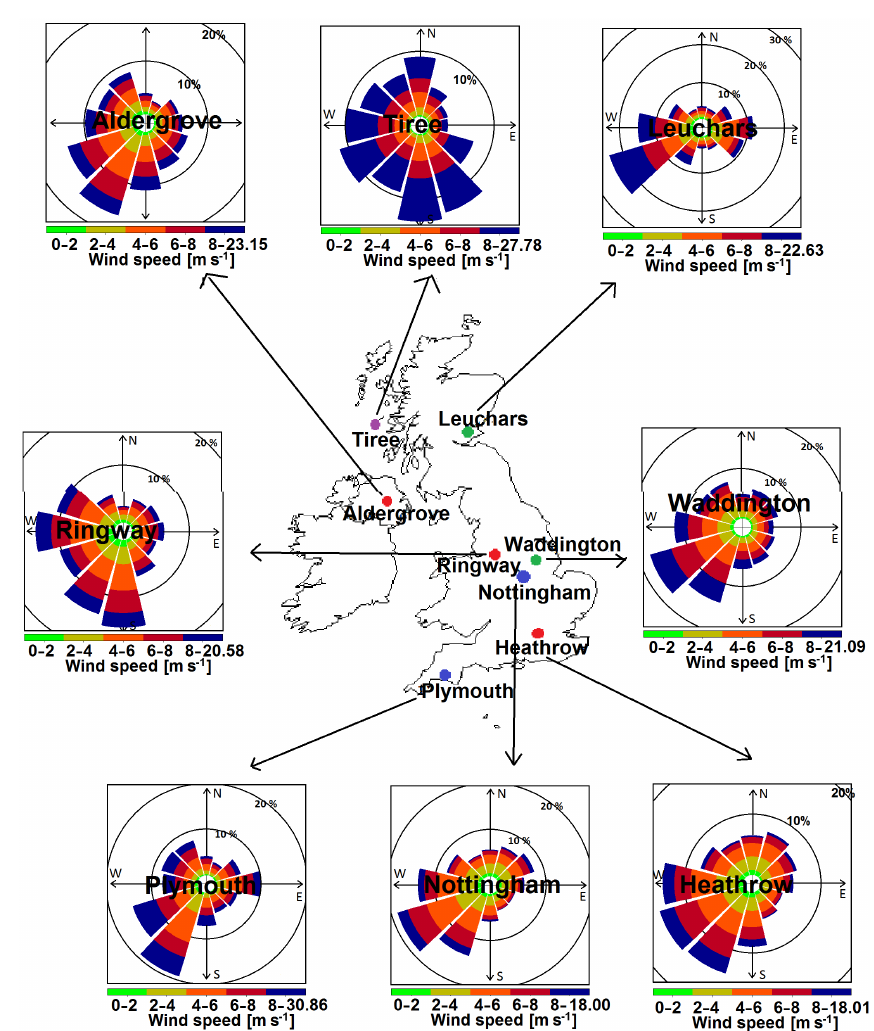
Figure 1. Geographical location of measurement stations used. Location point colours describe location type: red – urban airport; blue – urban; purple – rural/remote; and green – rural airport. Also presented are mean wind rose statistics for the whole time period (approximately 60 years) for all eight